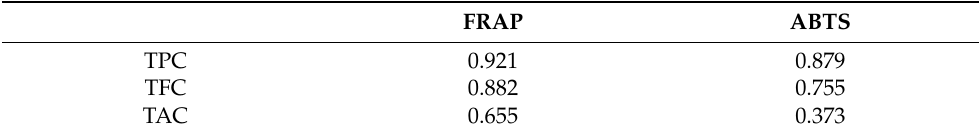
Table 4. Pearson correlations between phenolic compounds and antioxidant activity in raspberry